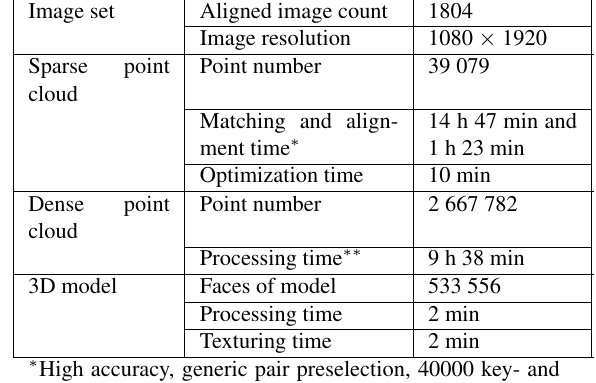
Table 1: Data about the imagery and models